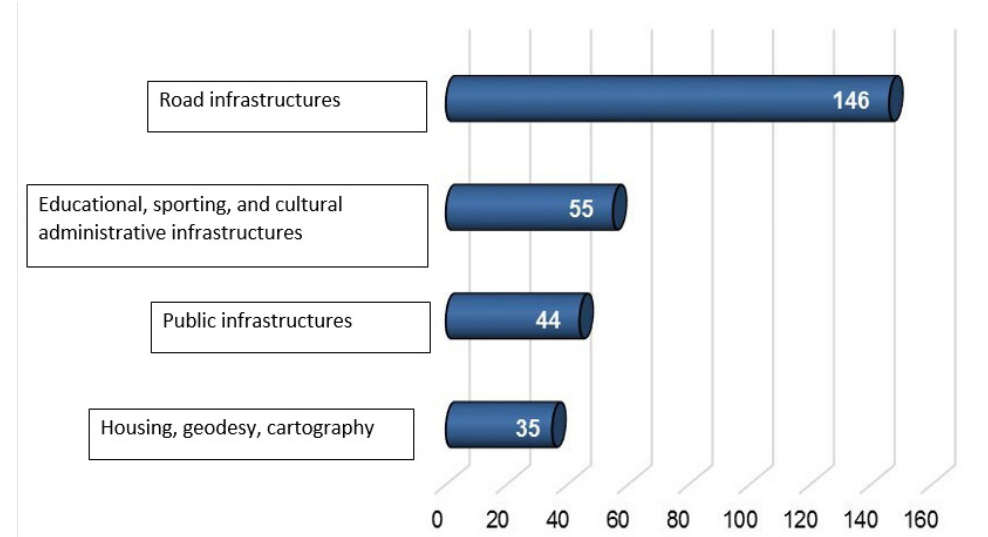
Figure 9. Public investments in Angola. Source: CEIC Report (CEIC 2013).